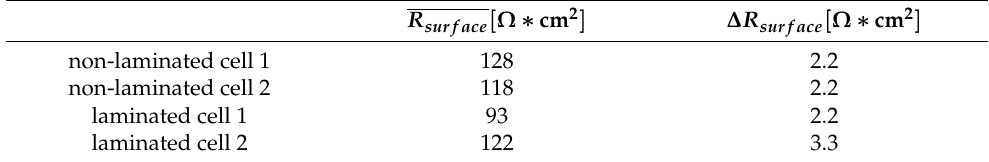
Table 1. Averaged surface resistance fit parameters of EIS analysis on cells with ceramic separator.